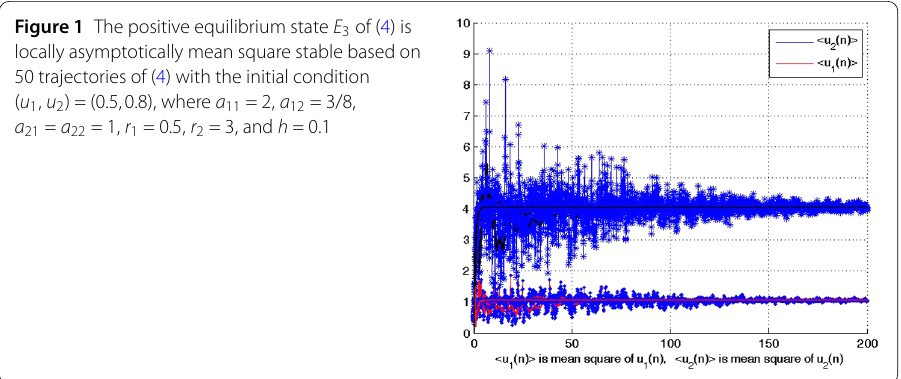
Figure 1 The positive equilibrium state E 3 of (4) is locally asymptotically mean square stable based on 50 trajectories of (4) with the initial condition ( u 1 , u 2 ) = (0.5,0.8), where a 11 = 2, a 12 = 3/8, a 21 = a 22 = 1, r 1 = 0.5, r 2 = 3, and h =